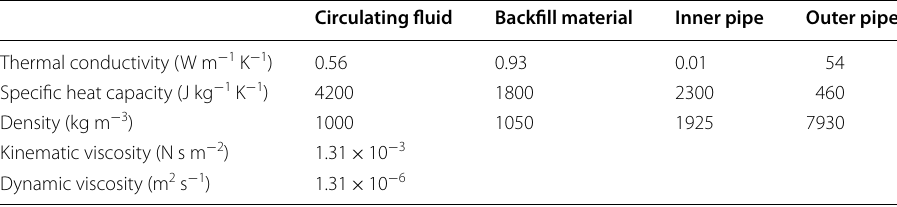
Table 6 Thermal parameters of the fluid, backfill material, inner pipe and outer pipe in the model Circulating